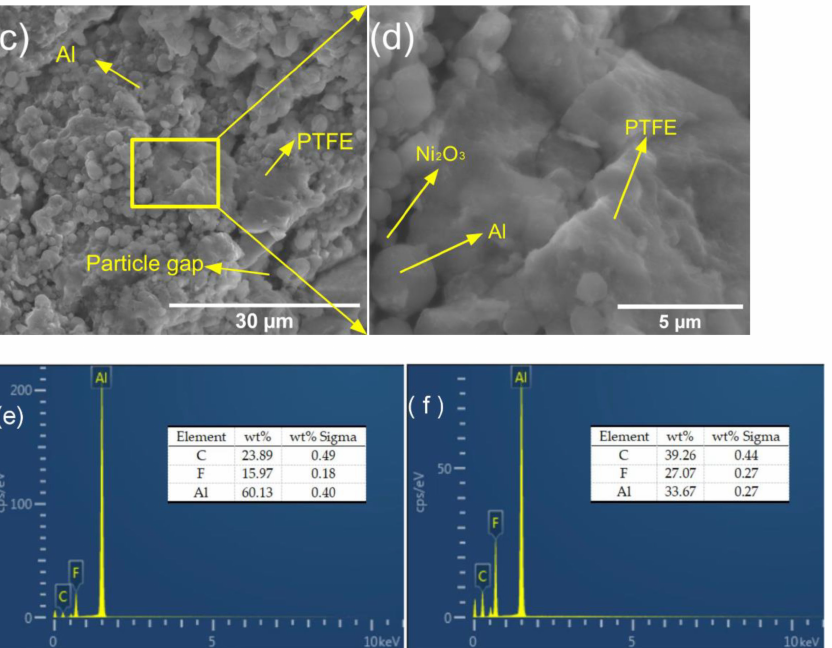
Figure 3. Microstructure of different reactive materials after sintering. ( a ) PTFE/Al; ( b ) PTFE/Al/CuO; ( c ) PTFE/Al/Ni 2 O 3 ; ( d ) Local magnification view of ( c ); ( e ) SEM at A point of ( a ); ( f ) SEM at B point of ( a ).